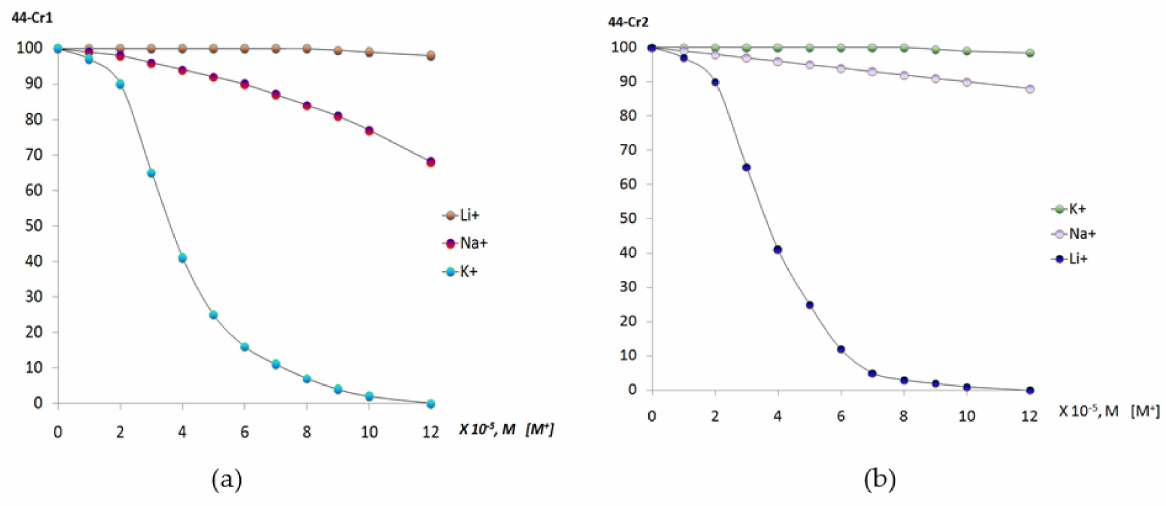
Figure 28. Destruction of the 79-Cr1 ( a ) and 79-Cr2 ( b ) complex following the interaction with LiBr, NaBr, and KBr in a toluene–methanol (9:1)